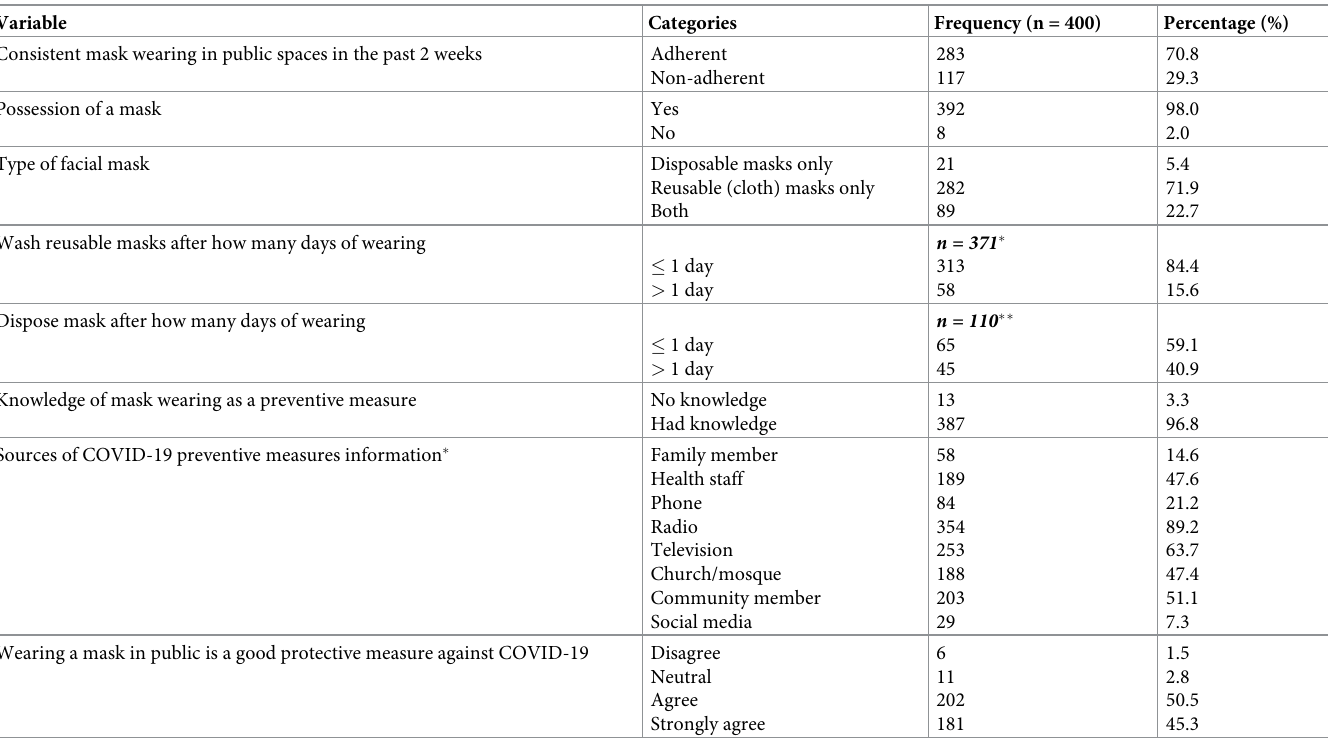
Table 2. Knowledge, attitudes, and practice of mask wearing.